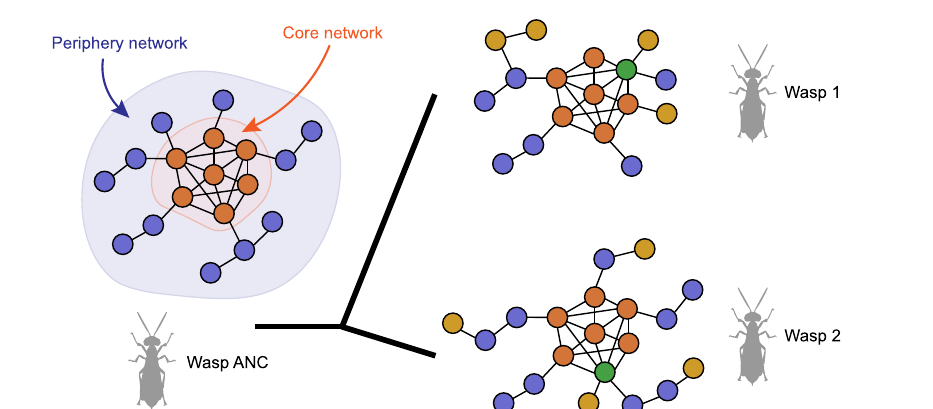
d Module shift analysis of the one-to-one orthologous non-venom genes in VRM between the two Anastatus wasps. The rank of the |kME| value (network con- nectivity)ofageneineachwaspispresentedonthe x -axis.Therugplotsabovethe x -axis show the rank distributions of genes in one wasp whose orthologs still keep in VRM (orange) or have shifted to other modules (light blue) in another wasp. e A schematic diagram for evolution of VRM in parasitoid wasps. A VRM could be roughly divided into two parts according to the network connectivity, i.e., core network and periphery network. During evolution, the periphery network shifts largely, which may be caused by network gene losses and new network gene recruitments(yellowpointsinWasp 1and Wasp2).Whilethecorenetworkismore conservative with only relatively few changes (green points). Wasp ANC, wasp ancestor. Figure created with BioRender.com. Source data are provided as a Source Data fi